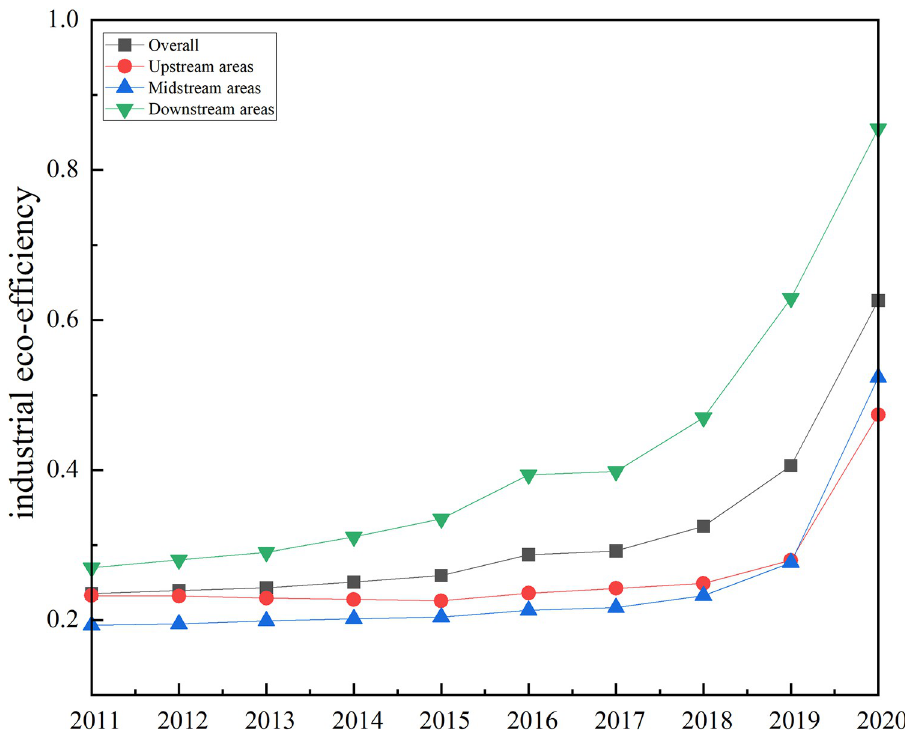
Fig 2. Change trend of industrial eco-efficiency in the Yangtze River Economic Belt from 2011 to 2020.